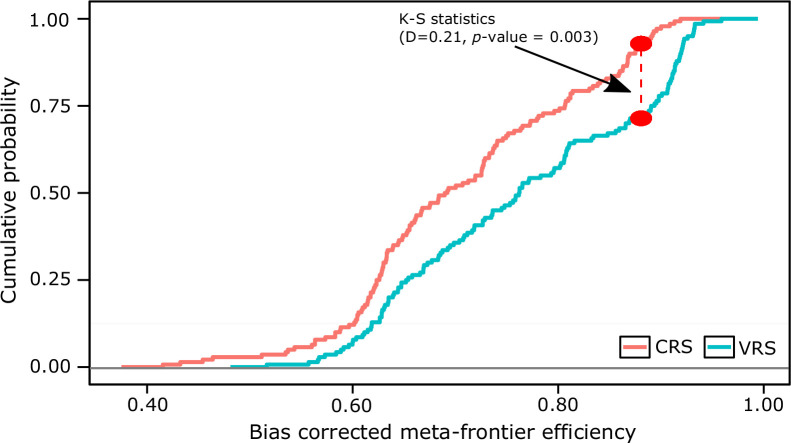
Cumulative probability distribution function, comparing the returns to
scale assumption (constant vs. variable return) of the sample data
(Kolmogorov–Smirnov test)